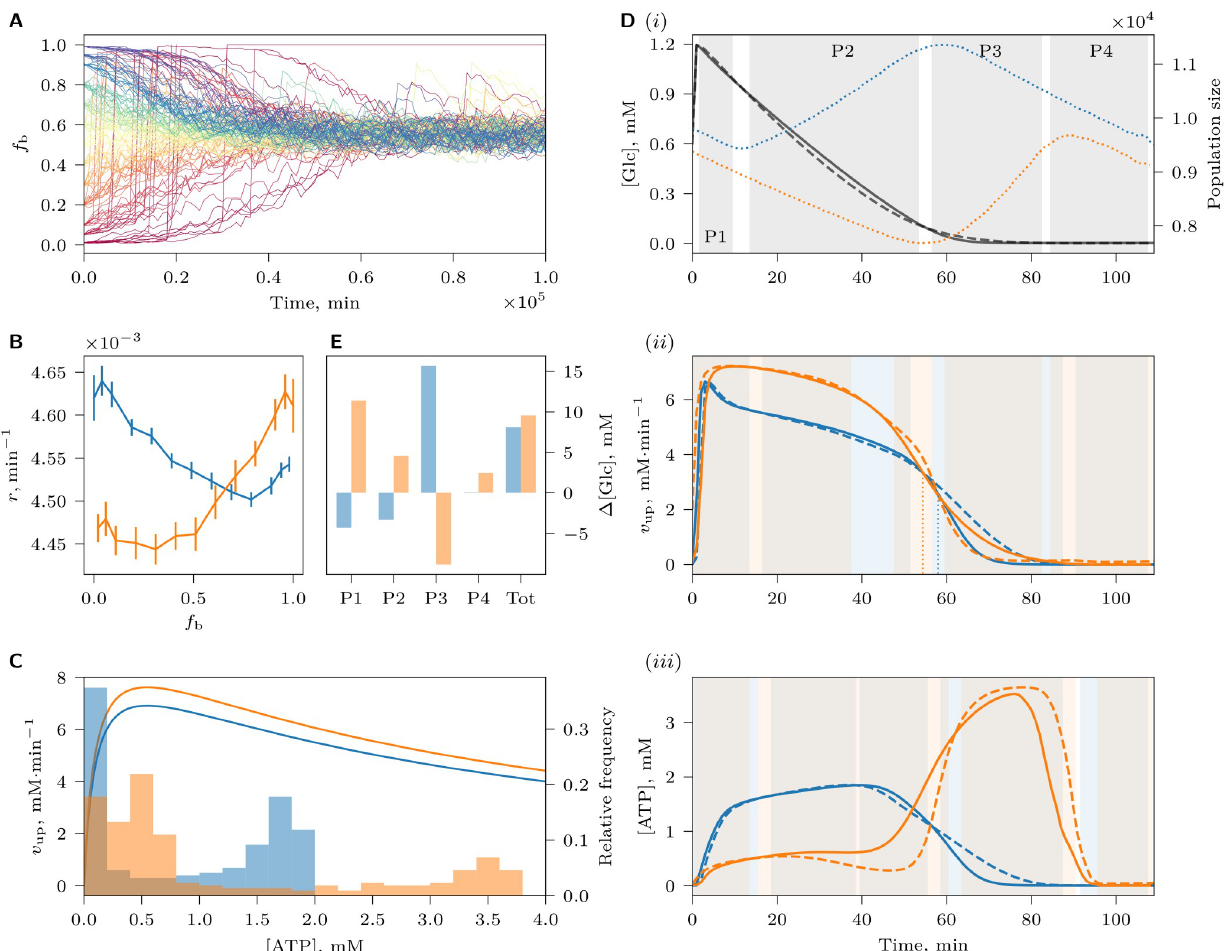
Fig 6. Negative frequency-dependence maintaining coexistence between BCs and ICs. (A) The joint population dynamics of two genotypes (Table 2), picked from the BC and IC subpopulations of the dimorphic population shown in Fig 5, was simulated under chemostat conditions as in Fig 5, but without mutation. Trajectories show the fraction of BCs ( f b ) in the population over time, for multiple different initial values of f b , indicated by color. In B, C, D(ii), D(iii) and E, data for BCs and ICs are shown in blue and orange, respectively. (B) Reproduction rate of BCs and ICs as a function of their fractions in the population. Error bars indicate confidence intervals ( α = 0.05) of the mean of the reproduction rates across simulation replicas. (C) Rate of UG, v up (lines, left axis), as a function of intracellular ATP concentration (Eq 1) for BCs and ICs at [Glc] = 2mM. Histograms (right axis) show the relative frequency distribution of intracellular ATP concentration values in BCs and ICs during an environmental cycle (shown in D(iii)). (D) Average glucose, v up and ATP dynamics during an environmental cycle (horizontal axis measures the time since the start of the glucose pulse) for a cell in a BCP ( f b = 0.99) or ICP ( f b = 0.01). (i) Average glucose concentration profile (left axis) in the chemostat chamber during an environmental cycle in a BCP (solid line) and an ICP (dashed line). Gray background indicates phases P1-P4 that are defined by a significant difference in the average glucose concentration between BCP and ICP ( α = 0.05, Bonferroni adjusted). Blue and orange dotted lines indicate average population sizes of BCP and ICP respectively (right axis). Due to the difference in the timing of reproduction of BCs and ICs, BCP and ICP show different size dynamics: BCP increases in size during the first half of the cycle when BCs reproduce, and decreases in size when reproduction stops and cells are only removed from the chemostat by the outflow. Conversely, ICP increases in size in the second half of the cycle, when ICs reproduce. (ii) Average v up and (iii) ATP dynamics during an environmental cycle, when the focal cell type is the dominant type (solid line) or the rare type (dashed line) in the population. Because the expression cost of an IC is higher than that of a BC (Table 2), an IC has to take up more glucose than a BC to maintain the same growth rate. Blue (resp., orange) background indicates phases where the averages shown by blue (resp., orange) curves differ significantly; gray background highlights phases where both differ within each pair. Dotted lines in (ii) indicate time points when glucose uptake flux v up in BCs and ICs becomes equal (in ICP, orange dotted line; in BCP, blue dotted line). (E) Advantage of rarity measured as the differential glucose uptake per unit cell volume, Δ [Glc], compared between populations where the focal cell type is rare versus dominant. Data are shown integrated over the entire environmental cycle (Tot), as well as separately for the phases P1-P4 (here, these include both shaded areas in D(i) and half of the adjacent white space between them). Due to demographic stochasticity, estimates in (B) and (D) were obtained by averaging over many environmental cycles after [Glc] in the chemostat had reached equilibrium and where f b had not deviated markedly from the considered value.